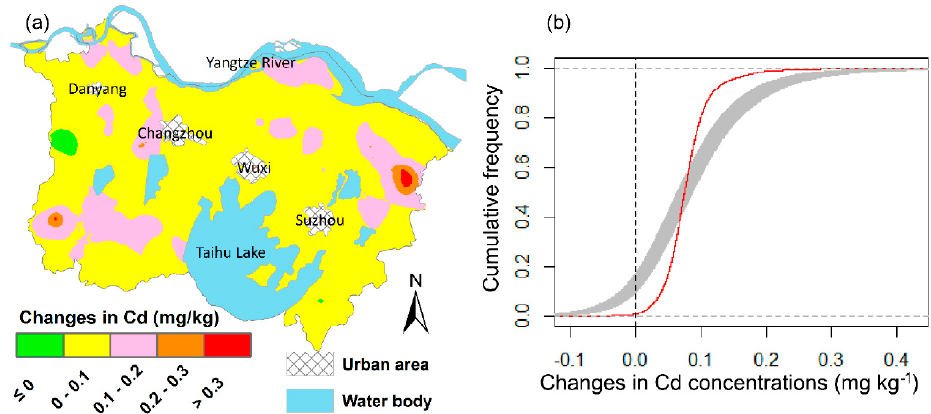
Figure 5. Spatial patterns ( a ) and cumulative frequency curves (b) of soil Cd change derived by ordinary kriging (shading area in Figure 5b is the uncertainty intervals of Cd changes).